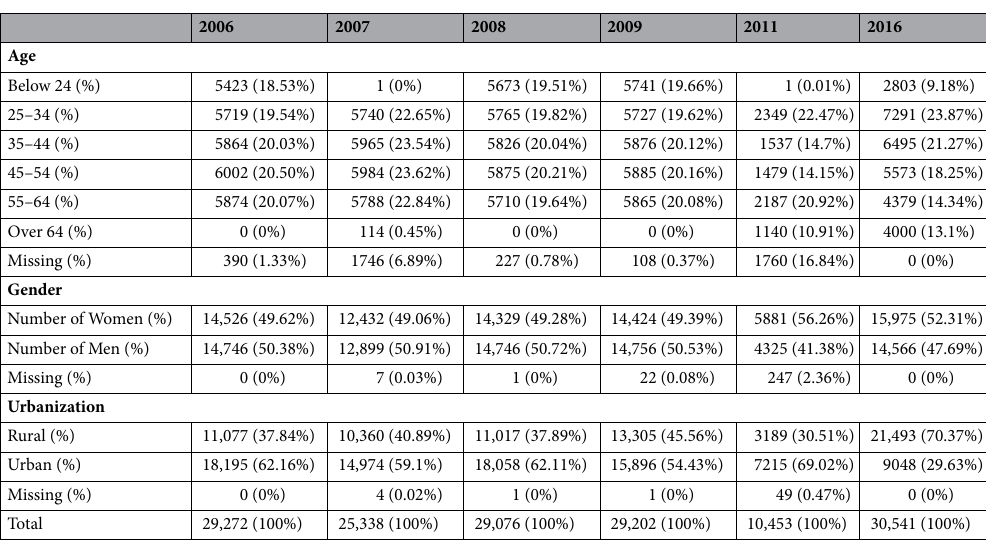
Table 1. Age, gender, and urbanization characteristics of participants in each STEPS survey. The STEPS survey 2005 was excluded from the study due to incoherence of its questionnaire with the next surveys. STEPS: STEPwise approach to